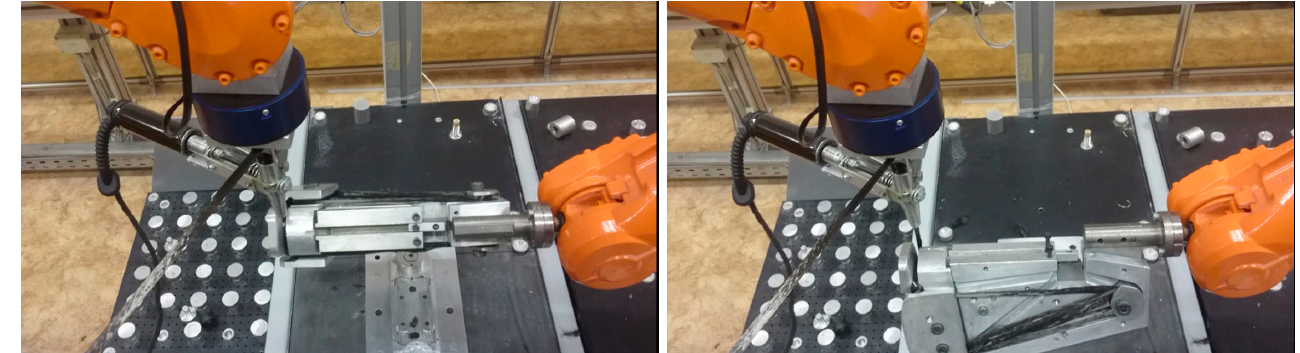
Figure 23. Winding dies rotation process.